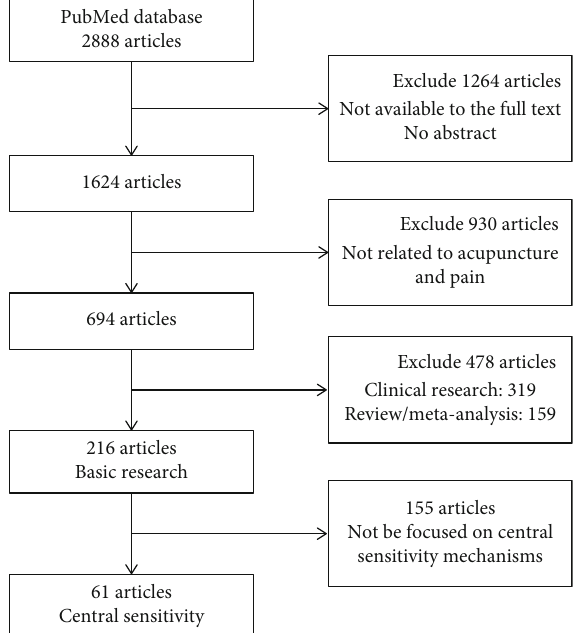
Figure 1: Flow chart of the search